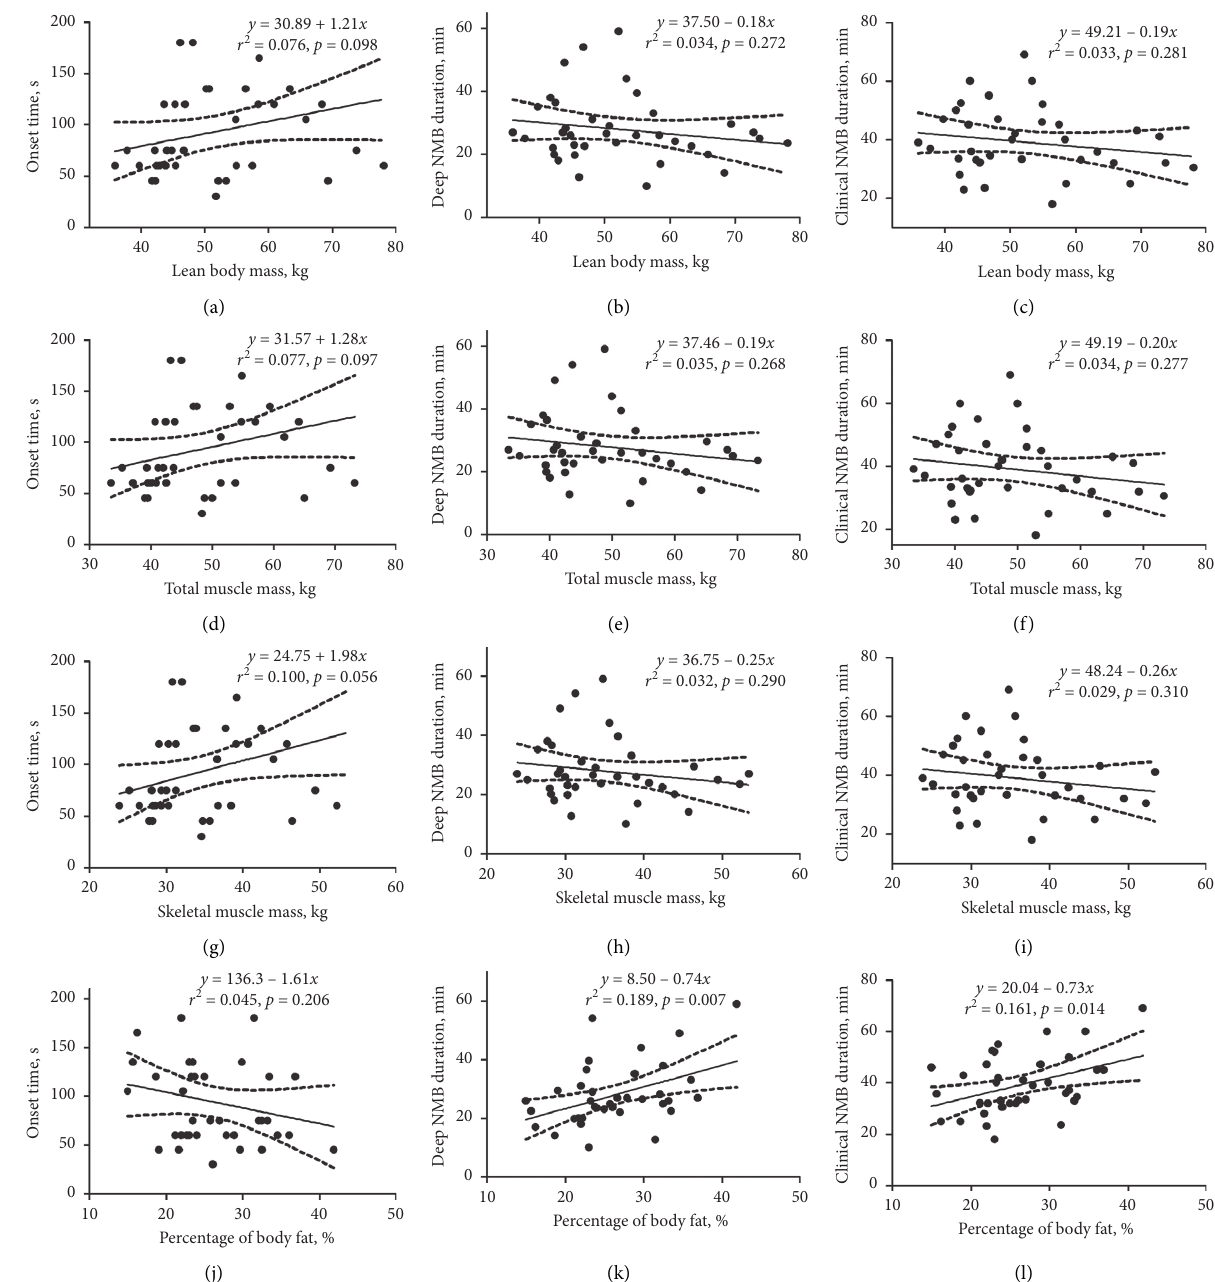
Figure 1: Scatter plots presenting correlations between body composition parameters and neuromuscular blockade (NMB) indexes. The body composition parameters include lean body mass, total muscle mass, skeletal muscle mass, and percentage of body fat. In each scatter plot, the solid straight line is the best fit line representing the linear regression result. The dashed curves on both sides of the best fit line indicate the 95% confidence interval. The linear regression equation, r 2 , and ( p ) value are labeled on the top right corner of the scatter